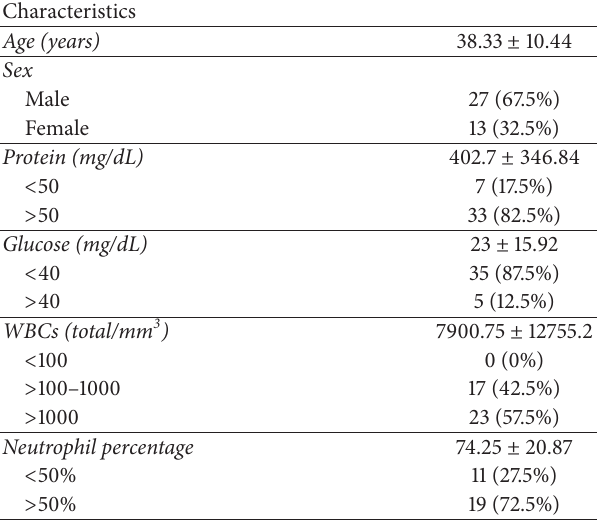
Table2:Demographic,biochemical,andcytologicaldataofpatients ( 𝑛 = 40 ).